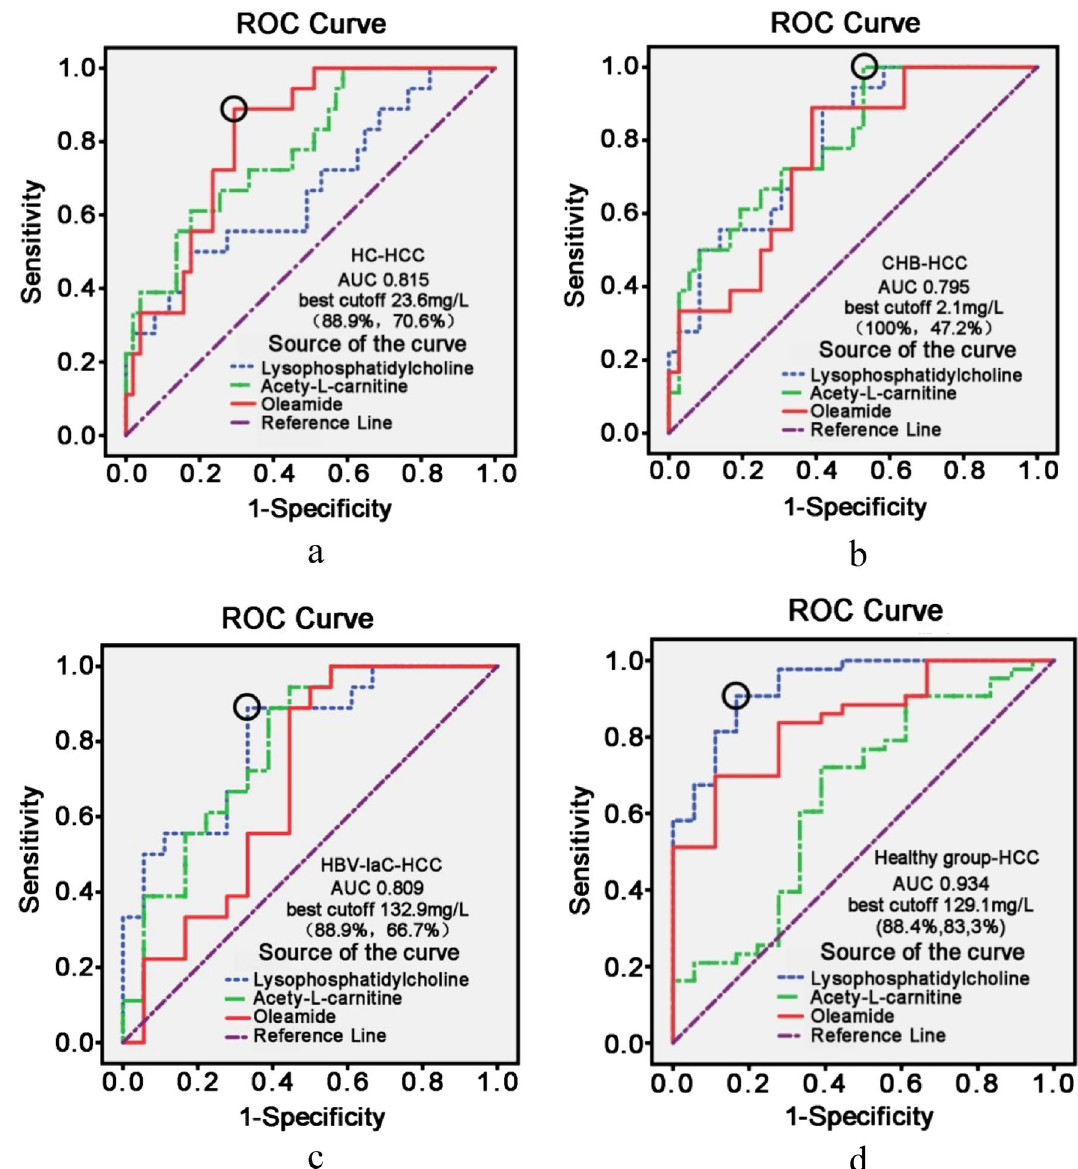
Figure 2. Results of the ROC curve analyses of the diagnostic values of different metabolites for HCC. ( a ) Hepatic cirrhosis-hepatocellular carcinoma. The ROC curve provided the largest AUC of 0.815 and the sensitivities and specificities reached 88.9% and 70.6%, respectively. ( b ) Chronic hepetitis B-hepatocellular carcinoma. The results of ROC curve: 0.792, 0.795, and 0.752. ( c ) Inactive HBV carrier-hepatocellular carcinoma. The ROC curve provided the largest AUC of 0.809 and the sensitivities and specificities reached 88.9% and 66.7%, respectively. ( d ) Healthy group-hepatocellular carcinoma. The ROC curve provided the largest AUC of 0.934 and the sensitivities, and specificities reached 88.4% and 83.3%, in the patients with DHC and HCC. The existing research suggests that the continuous elevation of serum glycocholic acid concentration in the patients with hepatitis B to levels higher than normal indicates that the patients may have substantial liver injury. The recovery of the serum glycocholic acid indicator may be used as a criterion for the recovery of liver function and a criterion for the curability of the liver diseases, indicating that the patient may be discharged. The changes in the serum glycocholic acid indicator may be used to set up the follow-up plan for disease monitoring in the patients with liver diseases. The ROC curve is based on a series of different two-category methods with the true positive rate (sensitivity) as the Y-axis and the false positive rate (1-specificity) as the X-axis. The curve is used to evaluate the discriminant effect and experimental performance; the higher the AUC, the higher the diagnostic accuracy. The ROC curves obtained in this study showed that different metabolites had certain diagnostic values for the diagnosis of HCC. Some of them showed better performance in the diagnostic experiment than others. Through the correspond- ing formula, the optimal cut-off value of each metabolite was obtained, showing the sensitivity and specificity